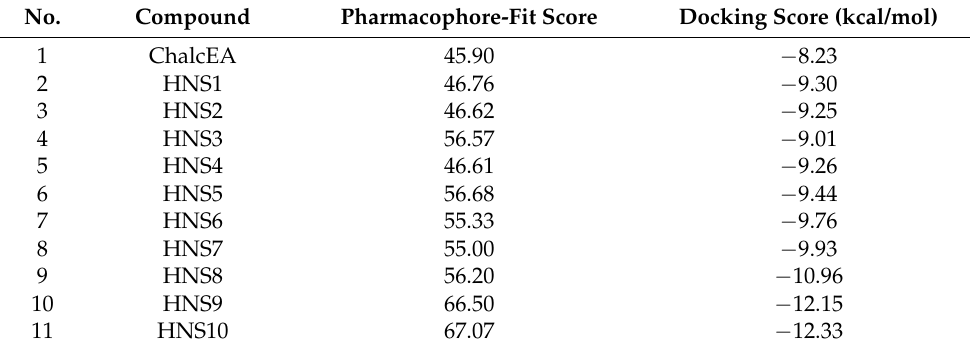
LigandScout pharmacophore fit score of ChalcEA derivatives retrieved using the 3D-structure-based pharmacophore derived from 4-hydroxytamoxifen (4-OHT) bound to the estrogen receptor alpha (ER α ). A higher fit score indicates a better geometric alignment of the features of